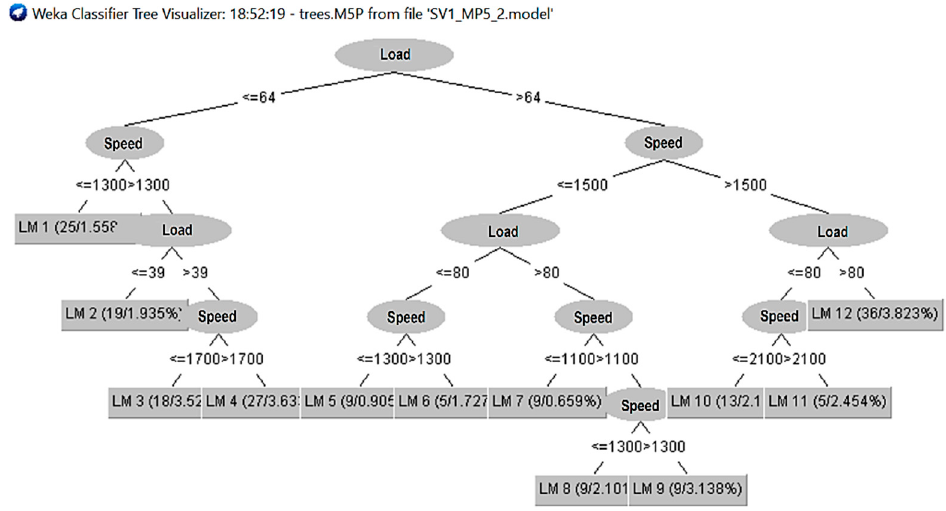
Figure 5. Tree view, LM (linear model) branches of the M5P algorithm applied to test-bench data.